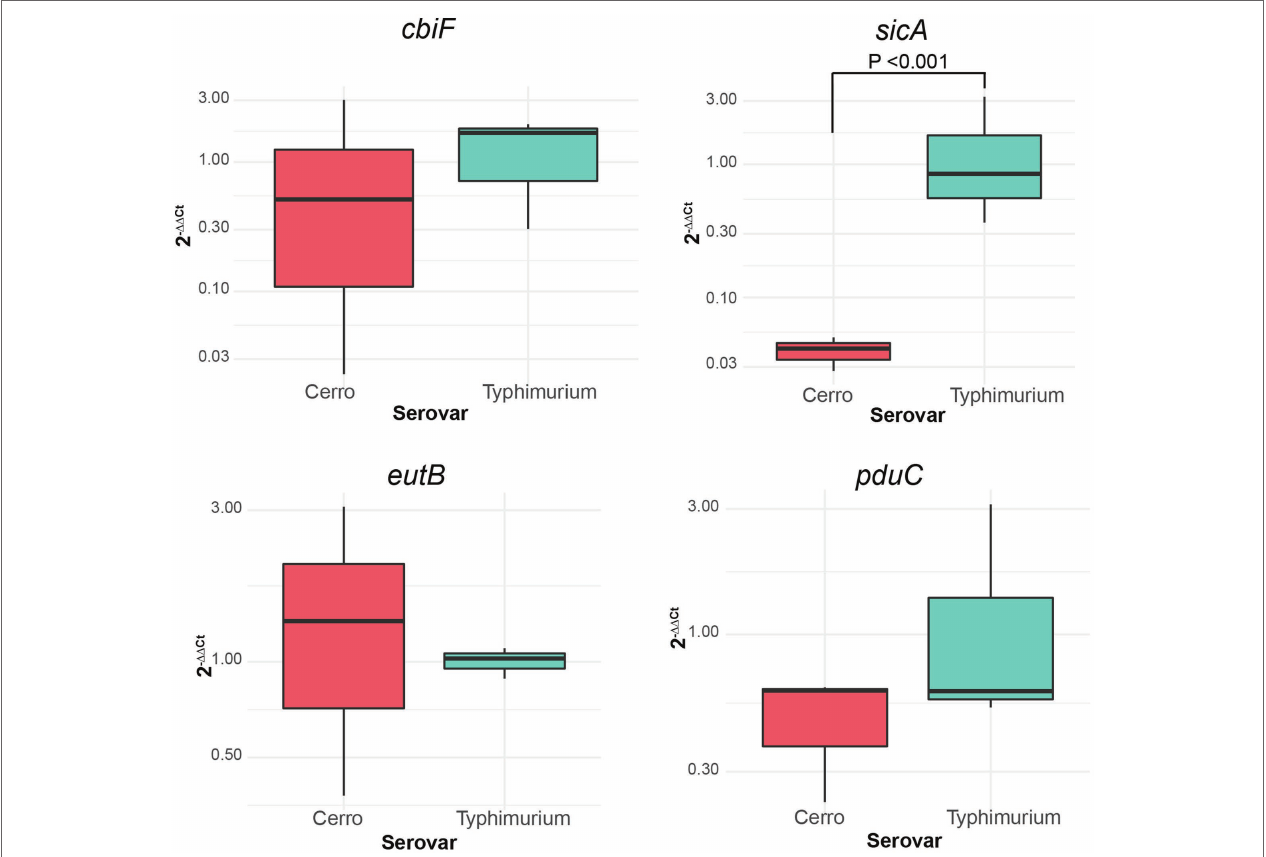
FIGURE 5 | qPCR demonstrates how inherent variability in undefined media can impact transcript abundances of genes involved in metabolic functions. Boxplots comparing the relative expression (2 −∆∆ Ct ) of cbiF ( cob operon; involved in vitamin B12 biosynthesis functions), eutB ( eut operon; ethanolamine utilization), pduC ( pdu operon; 1,2-propanediol utilization), and sicA (SPI-1 locus; T3SS-mediated invasion) of S. Cerro FSL R8-2349 and S. Typhimurium ATCC 14028S normalized to the expression of rpoB . Results represent three independent replicates performed in technical duplicate. Significance was assessed with ANOVA after fitting a linear mixed effects model to the relative expression data and calculating least square